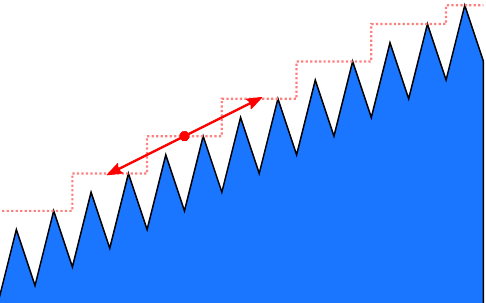
Figure 5. The calculation of the gradient of a roof requires a reduction in the resolution. “Micro”- structures can have arbitrary gradients in the smallest resolution (blue), which are not reflected in the “macro”-structure (red).